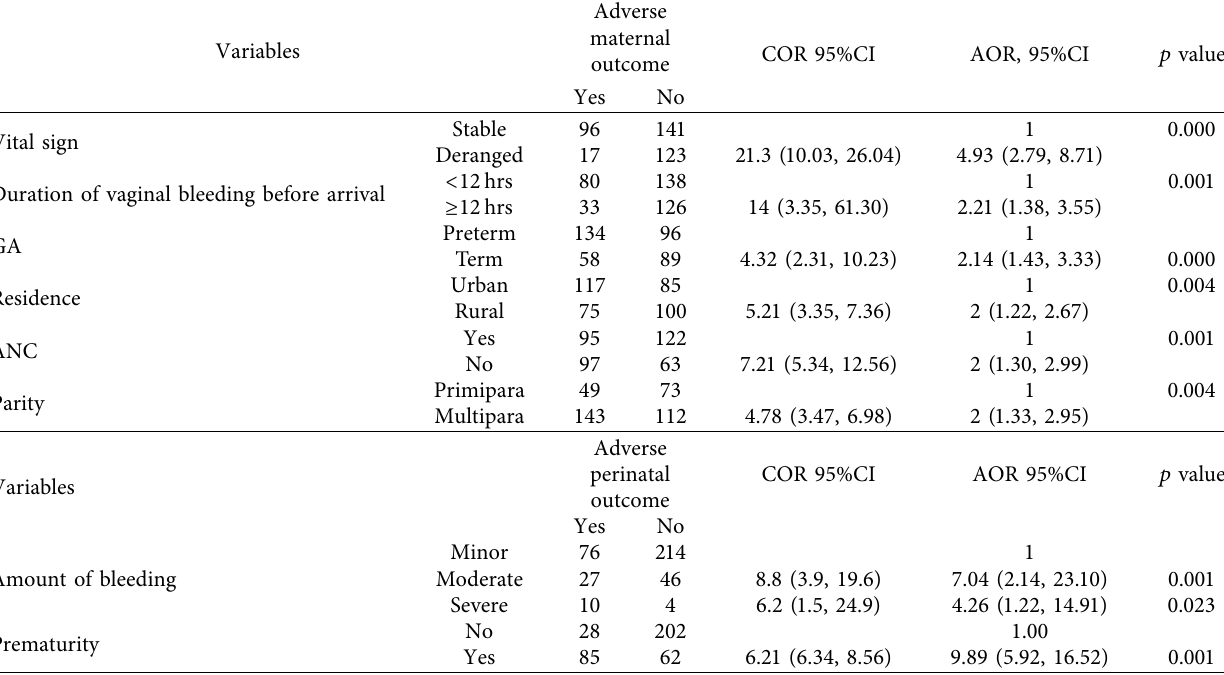
Table 7: Multiple logistic regression analysis: maternal complication among women admitted with antepartum hemorrhage in Jimma University Medical Center,